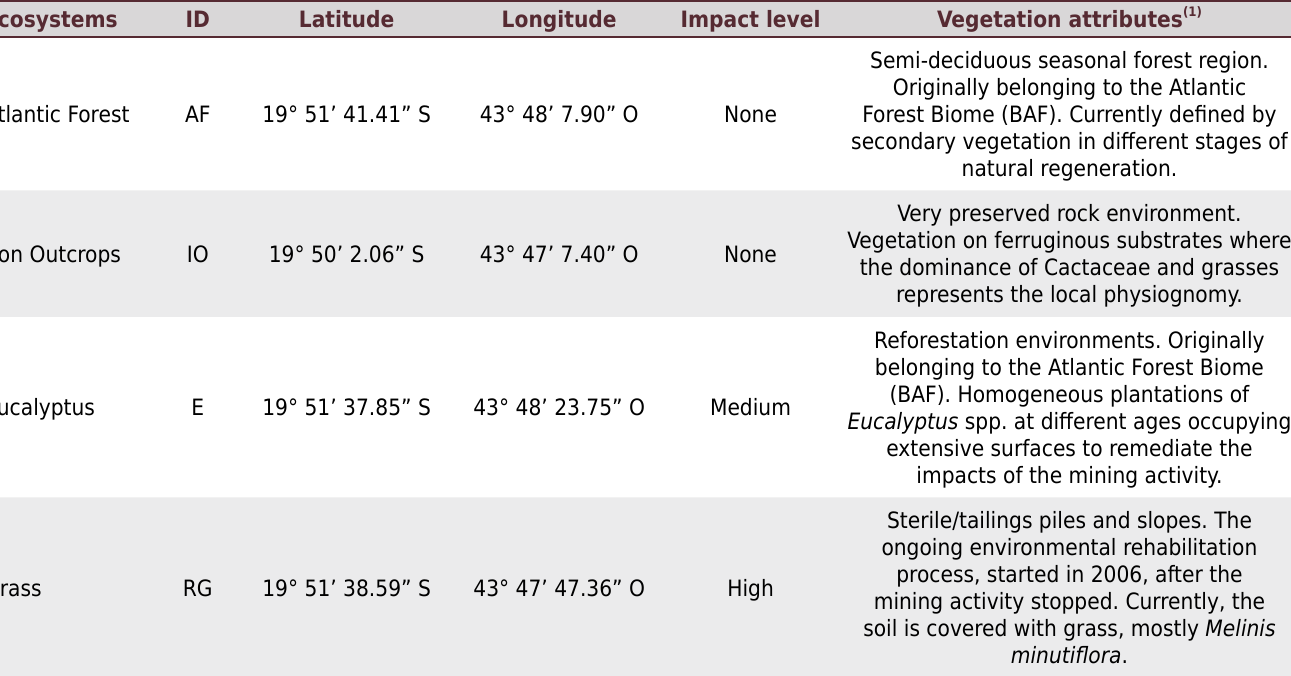
Table 1. Description of the ecosystems sampled in this study. The description of the soil properties can be found in Moreira and Vale (2018) Ecosystems ID Latitude Longitude Impact level Vegetation attributes (1) Atlantic Forest None